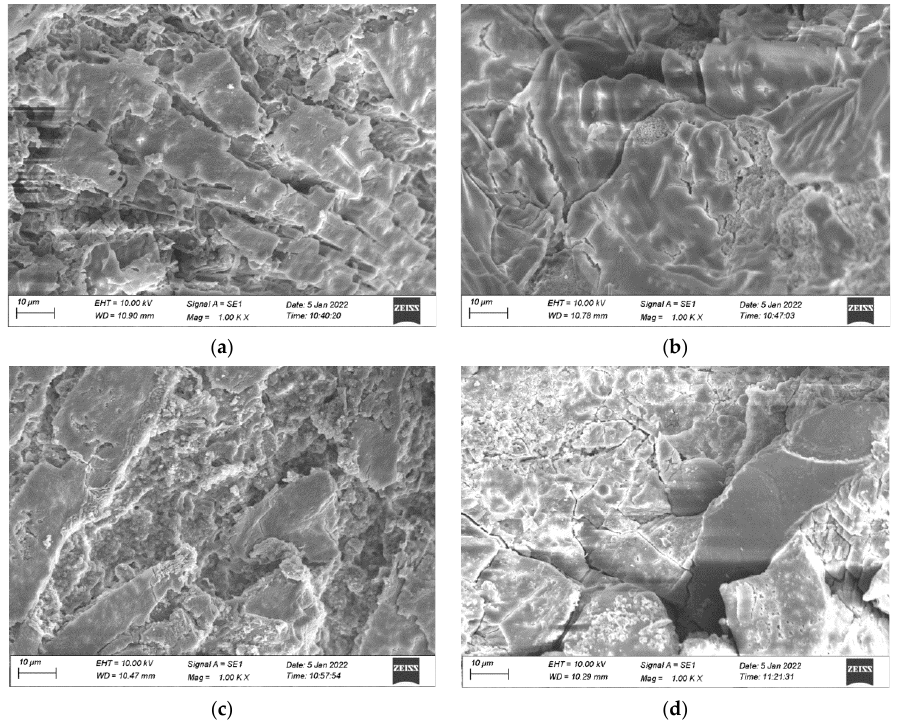
Figure 10. The microscopic morphology of MKPC at the age of 28 days with M:P = 2:1. ( a ) A0; ( b ) A1; ( c ) A2; ( d )